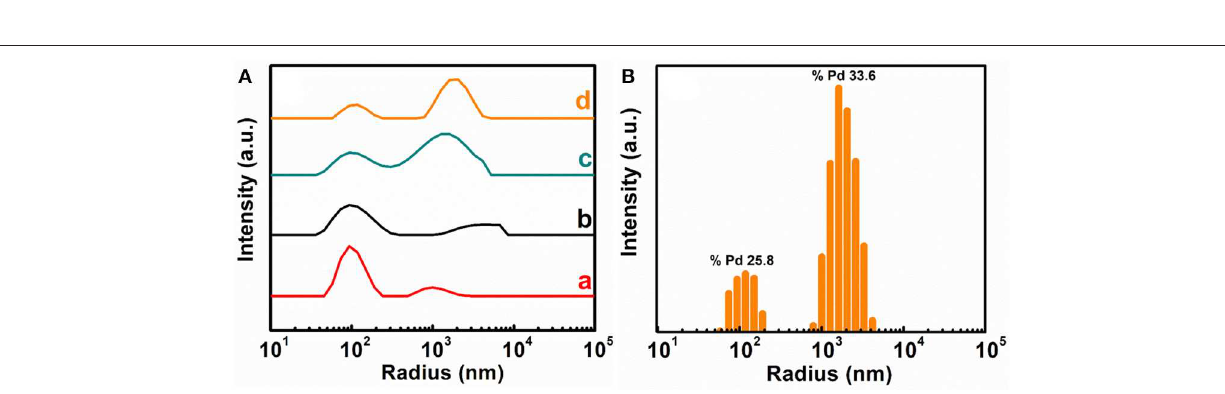
Frontiers in Energy Research |